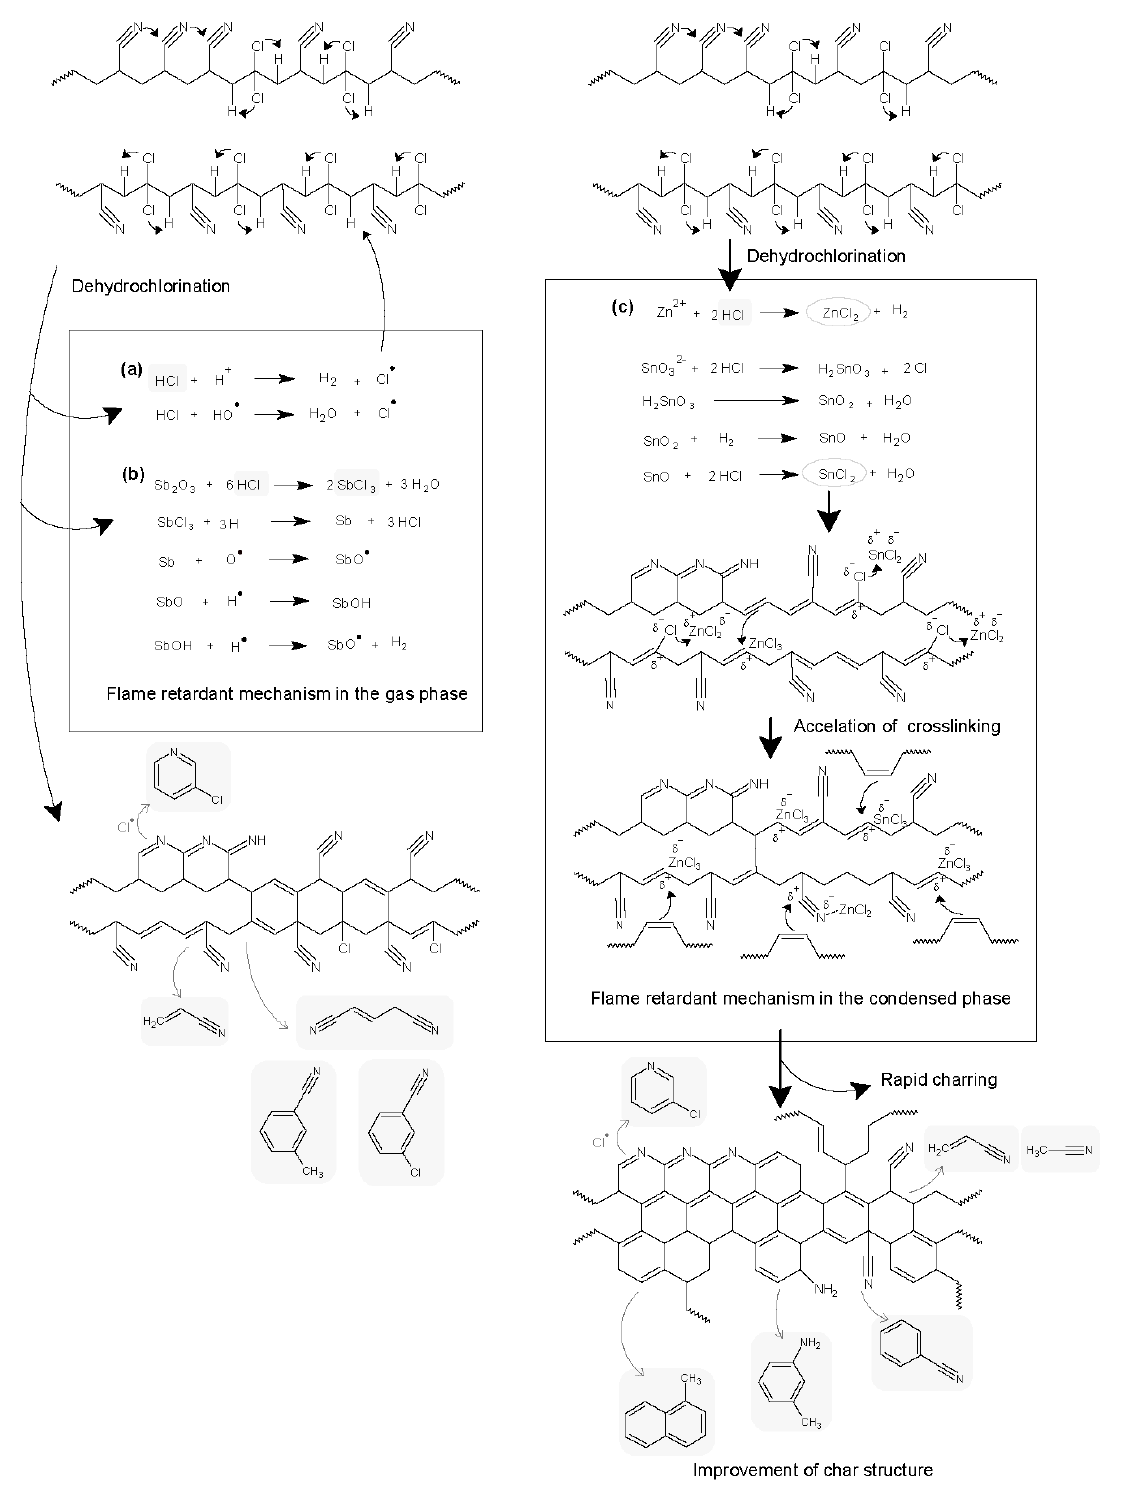
Figure 4. The flame retardant mechanism of ( a ) PANVDC, ( b ) PANVDC-ATO, and ( c ) PANVDC-